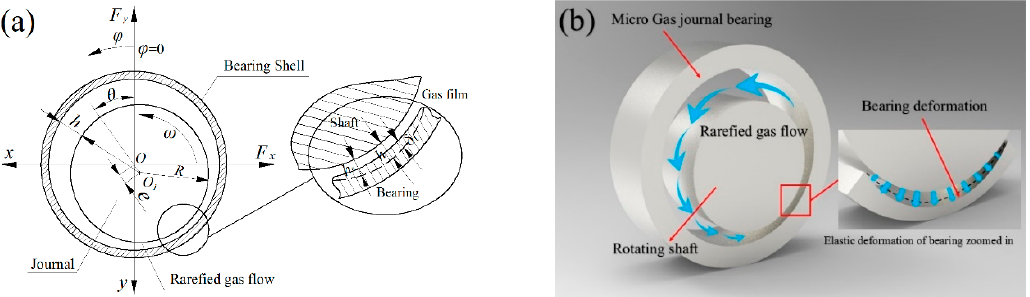
Figure 1. ( a ) Schematic and ( b ) 3-dimensional graphical representation of a gas lubricated microbearing considering elastic deformation of the bearing surface.